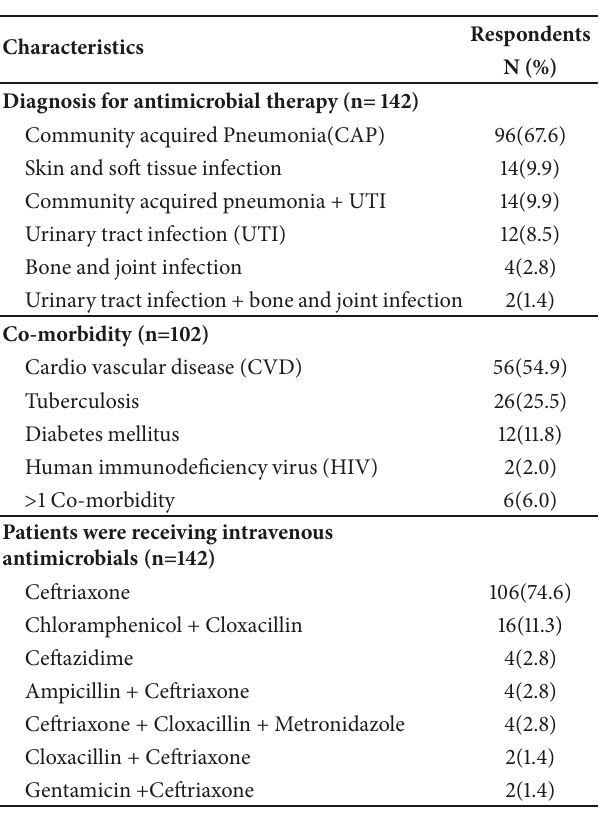
Table 2: Pattern of diseases and prescribed drugs for intravenous to oral converting practice at Jimma University Specialized Hospital, South West Ethiopia, February–September, 2014 (n=142 ).